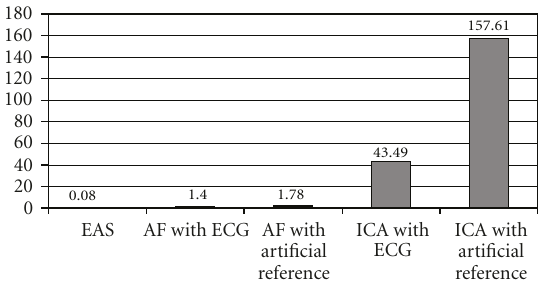
Figure 18: Average computing time (in seconds) to process a 15 minutes excerpt of polysomnographic signals in Matlab on a Pentium IV